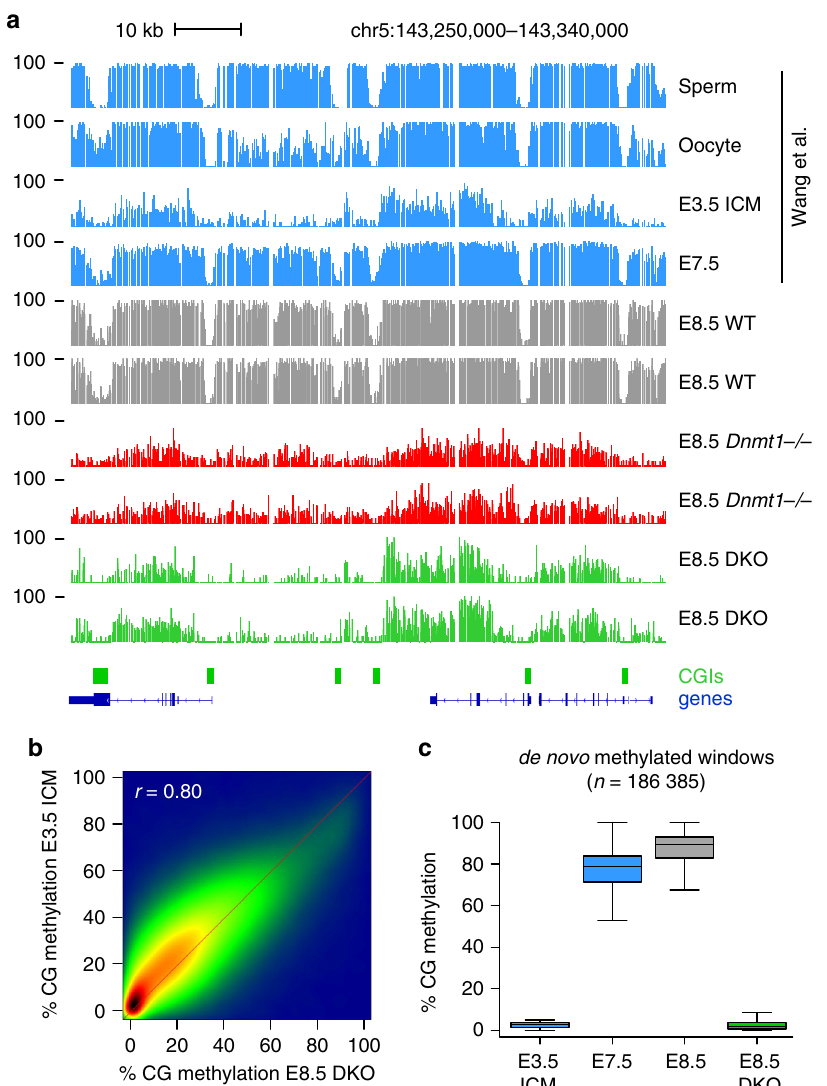
Fig. 2 Absence of de novo methylation in DKO embryos. a Genome browser tracks of WGBS methylation pro fi les in gametes, early embryos 31 , and E8.5 Dnmt mutant embryos, highlighting the strong similarity of methylation patterns between the ICM (Inner Cell Mass) and DKO embryos. CpG islands (CGIs) depicted by green rectangles and RefSeq gene annotations are shown below the tracks. b Density scatter plot of WGBS methylation scores in 1 kb windows in E8.5 DKO embryos compared with E3.5 ICM. The density of points increases from blue to dark red. c Boxplots of the CG methylation levels in ICM, postimplantation embryos, and E8.5 DKO embryos for all genomic windows de novo methylated at implantation, illustrating that de novo methylation is abolished in DKO embryos. In the boxplots the line indicates the median, the box limits indicate the upper and lower quartiles and the whiskers extend to 1.5 IQR from the